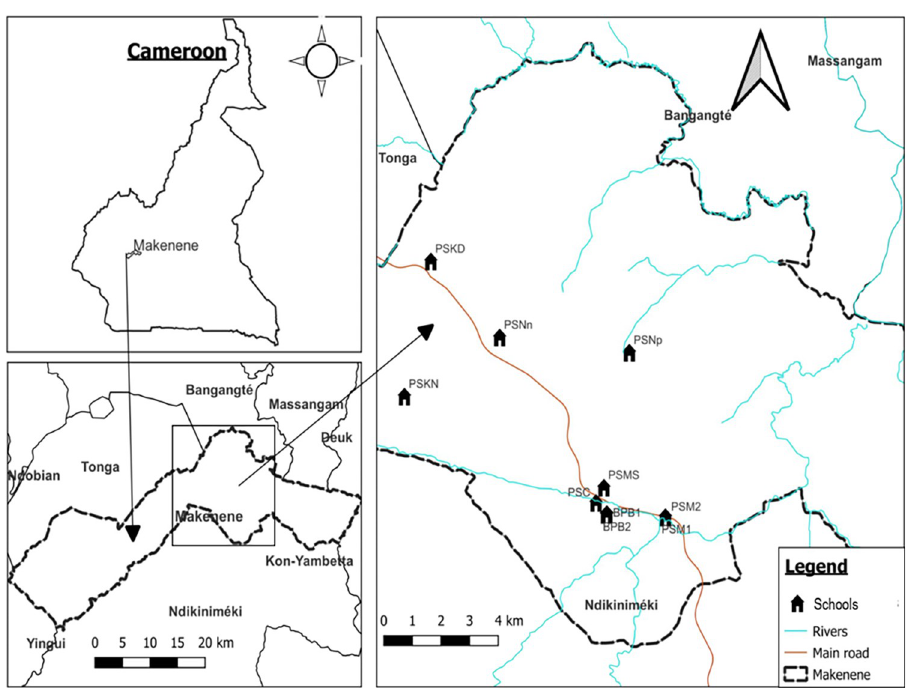
Fig 1. Map of Makenene showing schools where children were sampled (map obtained from: https://qgis.org/ downloads/QGIS-OSGeo4W-3.16.10-1-Setup-x86_64.exe with layers downloaded using the link: https://www.diva-gis. org/gdata; consulted, 14/09/2021). BPB1: Government bilingual primary school of Baloua group 1; BPB2: Government bilingual primary school of Baloua group 2; PSM1: Public school of Makenene group 1; PSM2: Public school